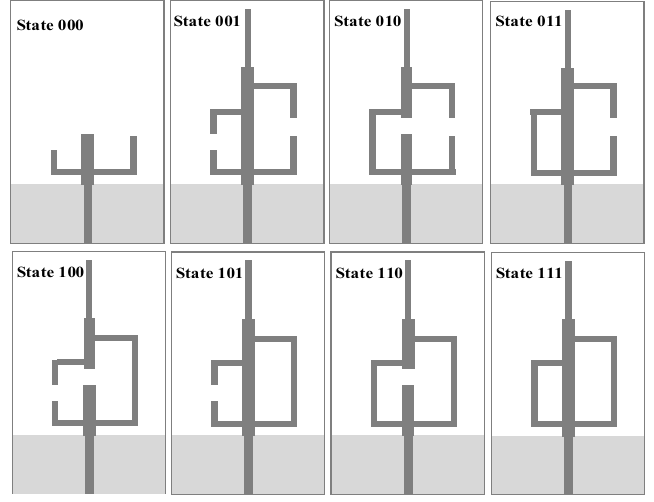
Figure 3. Equivalent structures of the STLS for different states.